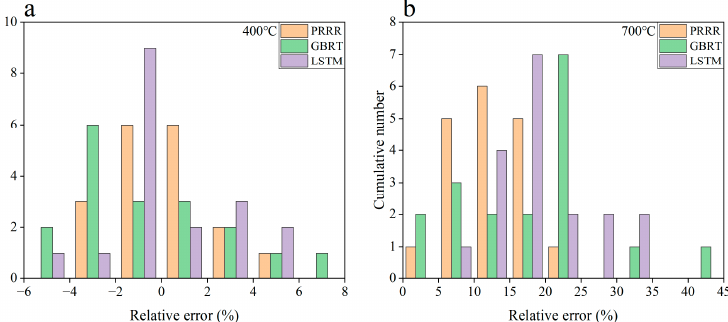
Figure 4. Relative errors of the predicted results to the experimental data for the different machine learning models in Figure 3: ( a ) 400 °C; ( b ) 700 °C. The range of relative errors is the same between the same numbers on the horizontal axis.